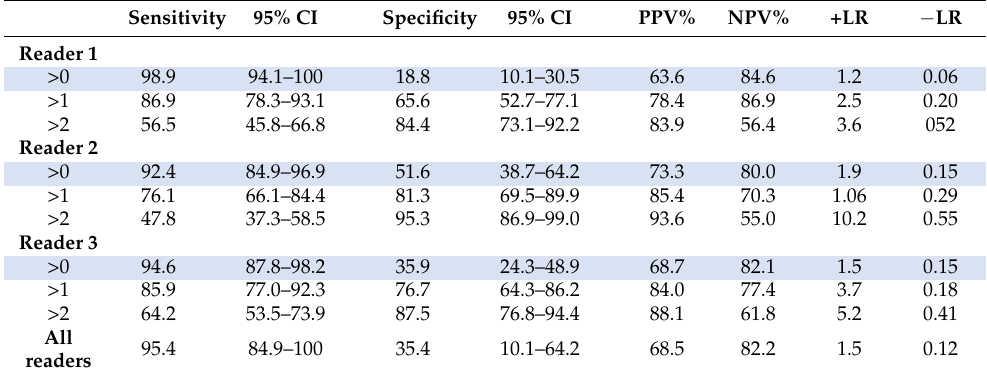
Inter-reader agreement for grading the enhancement intensity ranged from substan- tial (0.76 between R1 and R2, 0.79 between R1 and R3) to almost perfect (0.87 between R2 and